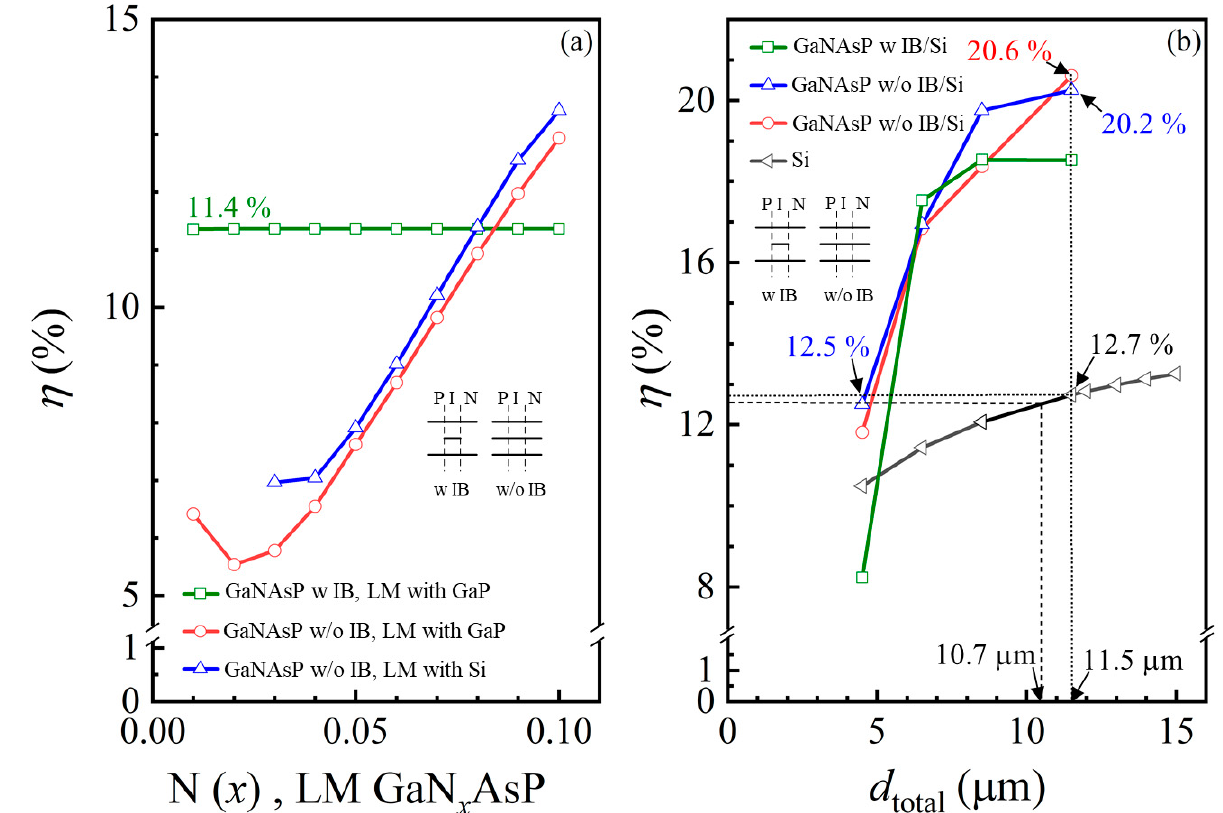
Figure 8. ( a ) PCEs ( η ) of the GaP-lattice-matched GaN x AsP-based IBSC (GaNAsP w IB, LM with GaP), the GaP-lattice-matched GaN x AsP (GaNAsP w/o IB, LM with GaP), and the Si-lattice-matched GaN x AsP (GaNAsP w/o IB, LM with Si) as a function of N( x ) with the different total thickness ( d total ); ( b ) The comparison between PCEs of GaNAsP/Si tandem cell and Si cell at different total thickness ( d total ). Each point of the GaNAsP/Si tandem cell represent the maximum PCE of each thickness combination.